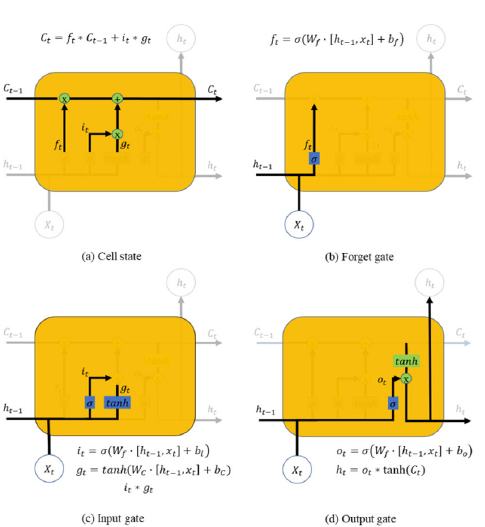
Fig. 9. LSTM network cell at time step t Fig. 10. The internal operation process of